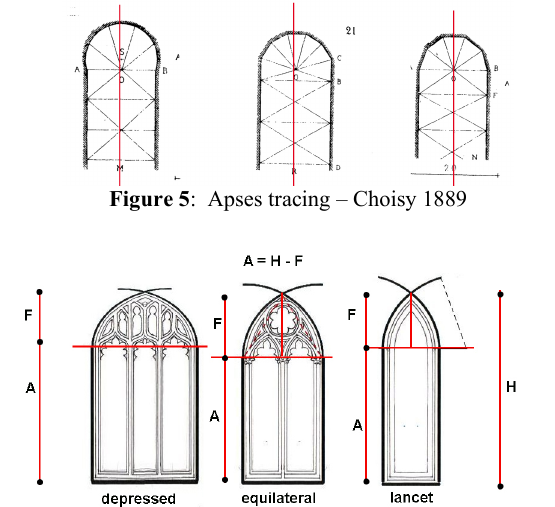
Figure 6 : some geometric rules for perimetral arches